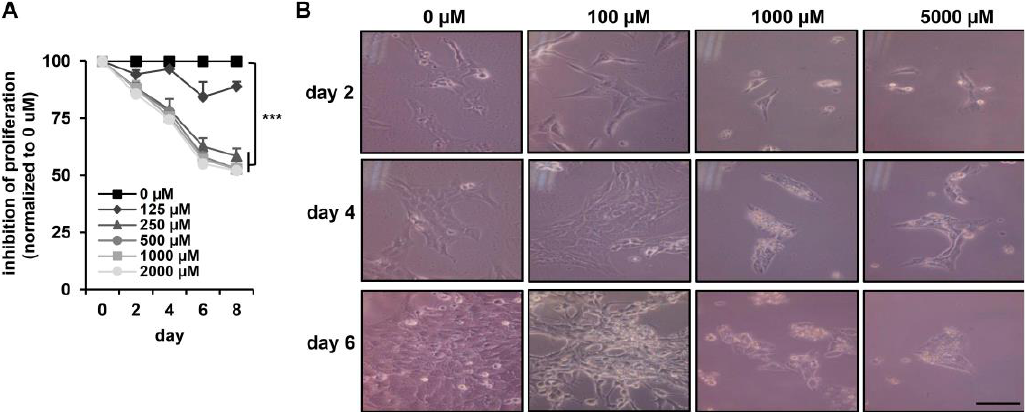
Figure 2. Cytotoxicity effects of DEHP in HSC-T6 cells. ( A ) HSC-T6 cells were exposed to DEHP at the indicated doses for two to eight days, and cell proliferation was assessed using an MTT assay kit. *** p < 0.001 vs. 0 µM. ( B ) Morphology of DEHP-treated HSC-T6 cells for two, four, and six days. Scale bar indicates 20 µm.